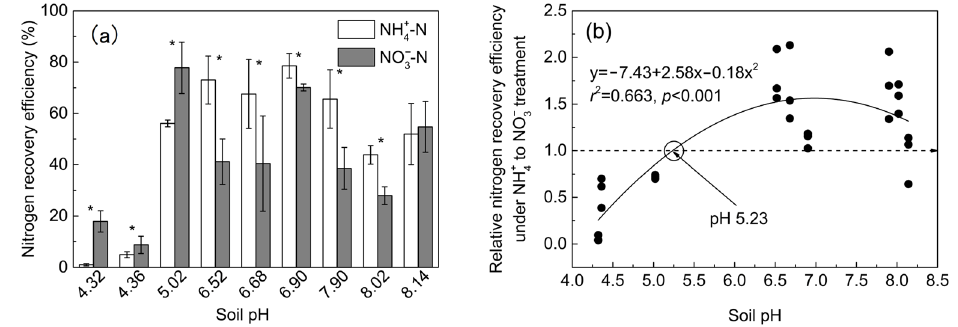
Figure 4. Effects of soil pH on the nitrogen recovery efficiency (NRE) response of maize to ammonium (NH 4+ ) and nitrate (NO 3 − ) fertilizers. NRE ( a ) and relative NRE ( b ). Maize seedlings were harvested after 30 days of growth. Relative NRE of maize was calculated as the ratio of NRE under NH 4+ treatment to that under NO 3− treatment. Asterisks indicate significant differences between NH 4+ and NO 3− treatments in the same soil.